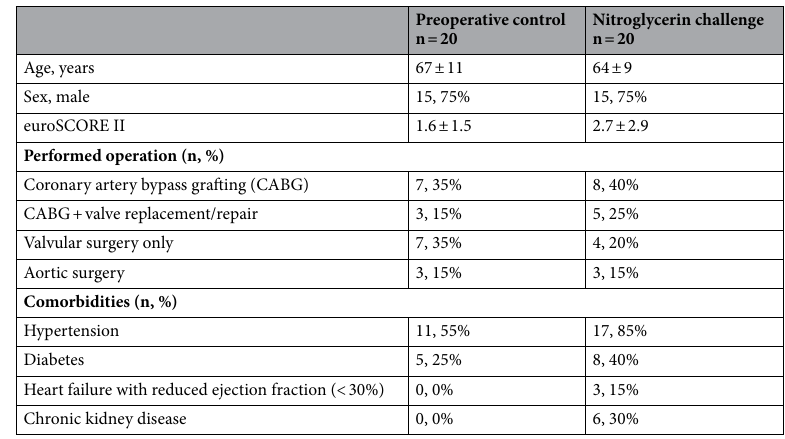
Table 1. Patient demographics.